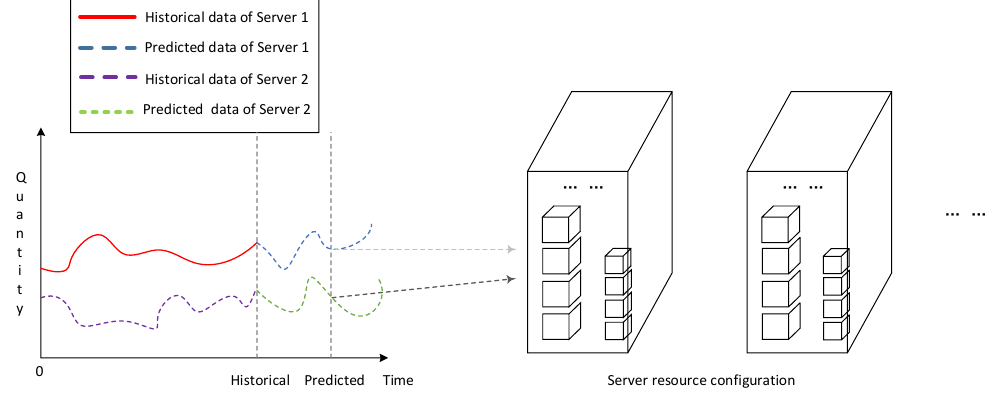
Figure 2. Cloud computing resource load short-term forecasting and resource optimization configuration.